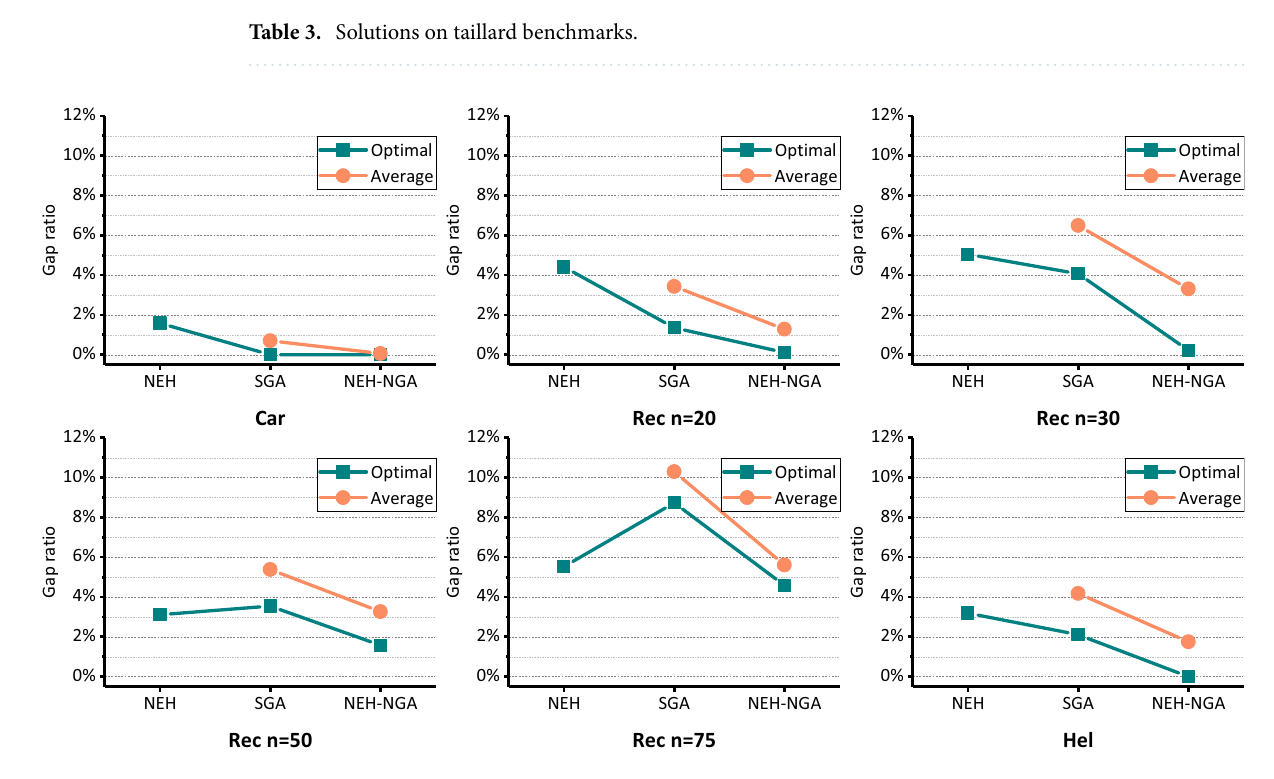
Figure 7. Comparison on Car, Rec and Hel